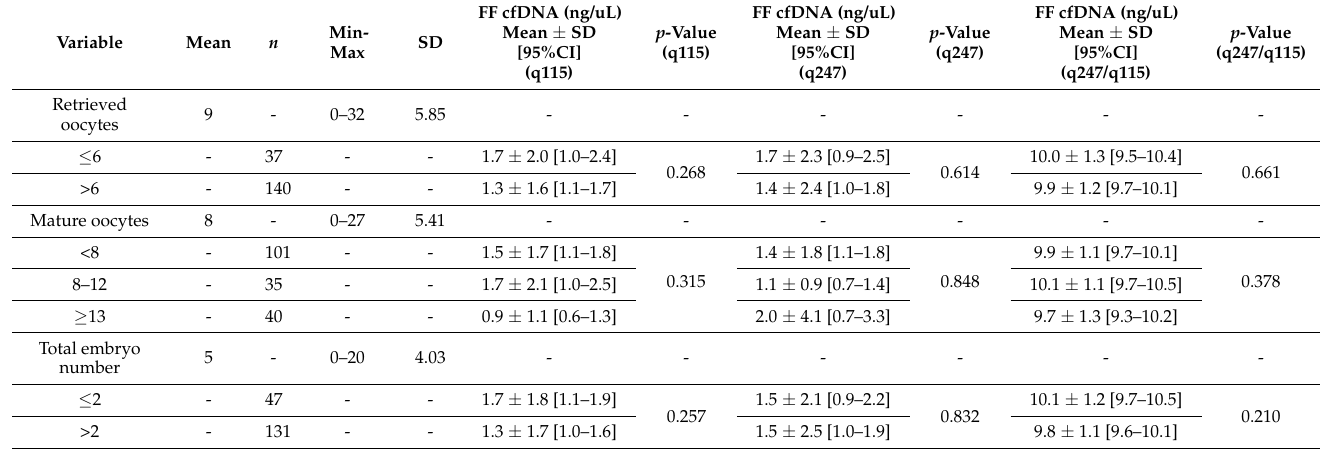
Table 5 includes the percentage of embryo fragmentation and beta chorionic go-